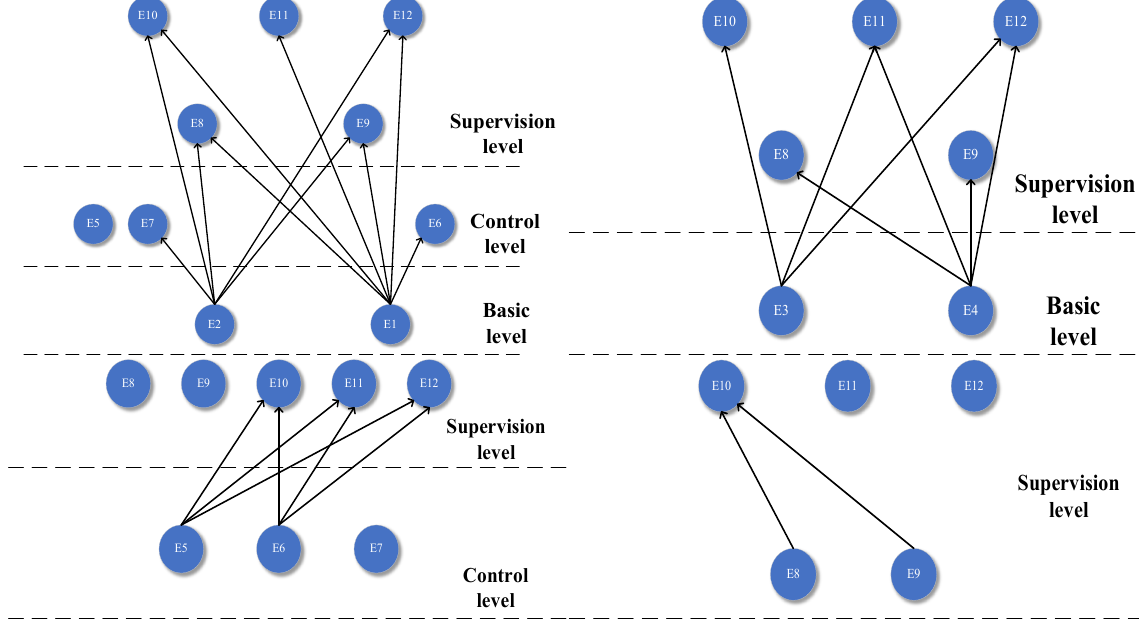
Figure 6. Hasse diagrams of non-coal mine explosion accidents.